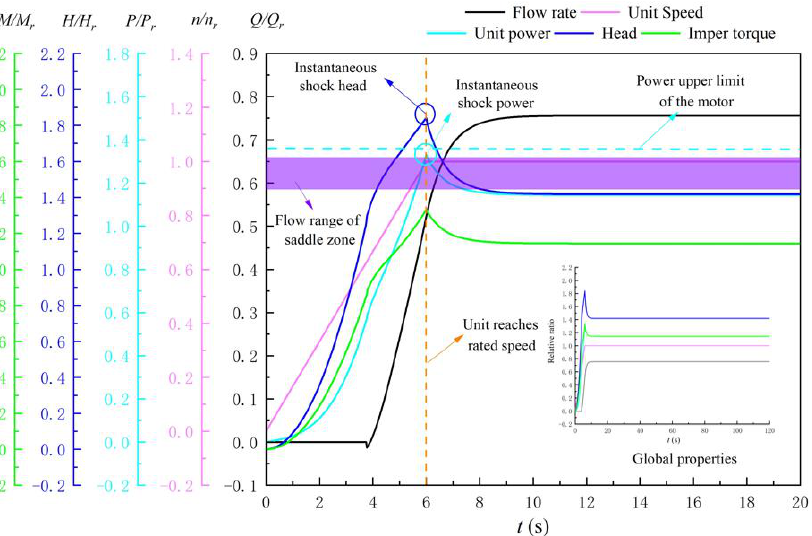
Figure 13. The start-up characteristic curve of LAPS equipped with 3.5 m 2 (26.4% A g ) FLVA under gate refusal working conditions.